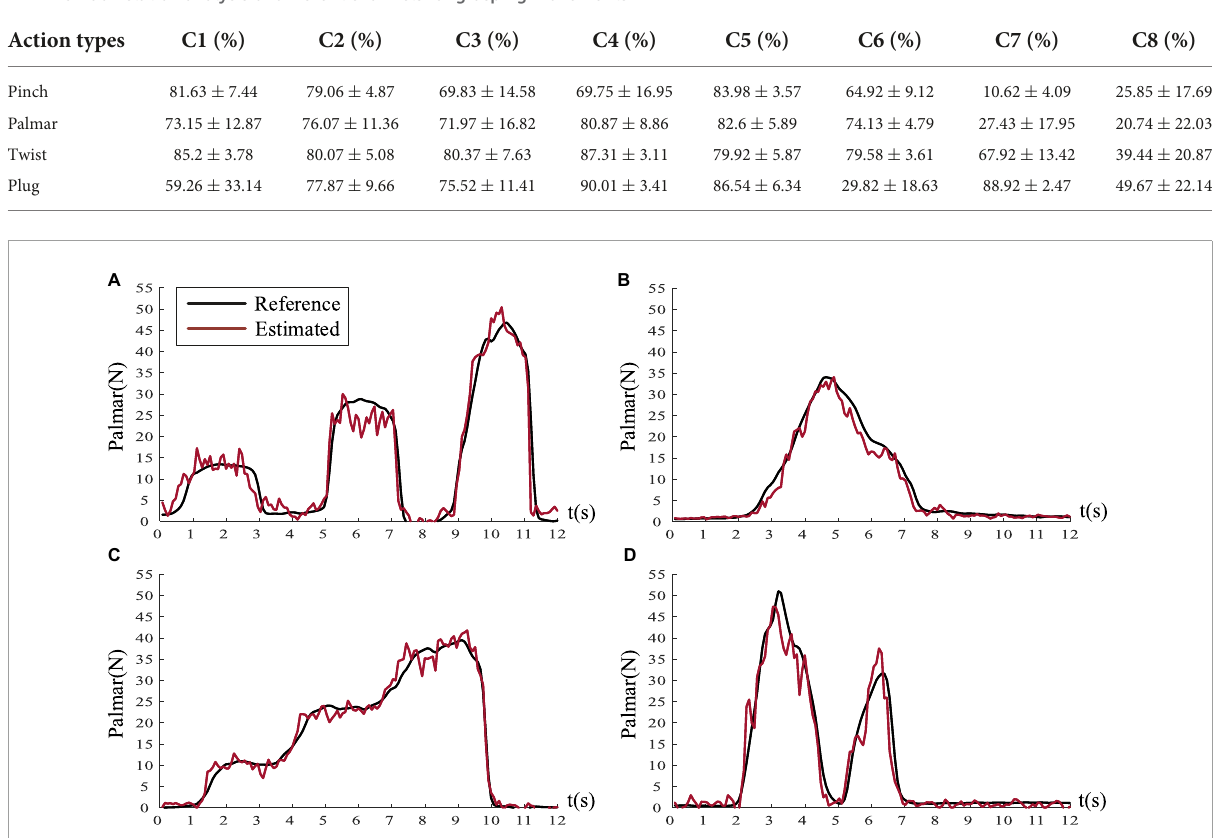
TABLE 3 Correlation analysis of different channels for grasping movements.